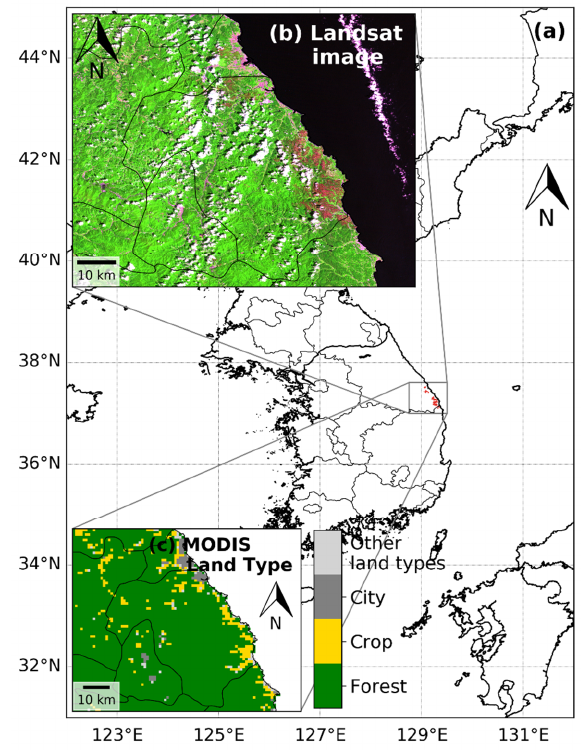
Figure 1. ( a ) Study area; ( b ) Three-band composite image of Landsat-5 consisting of Band 7 (short-wave infrared (SWIR)), Band 4 (near infrared (NIR)), and Band 3 (Red) in 13 August 2000; ( c ) Land type